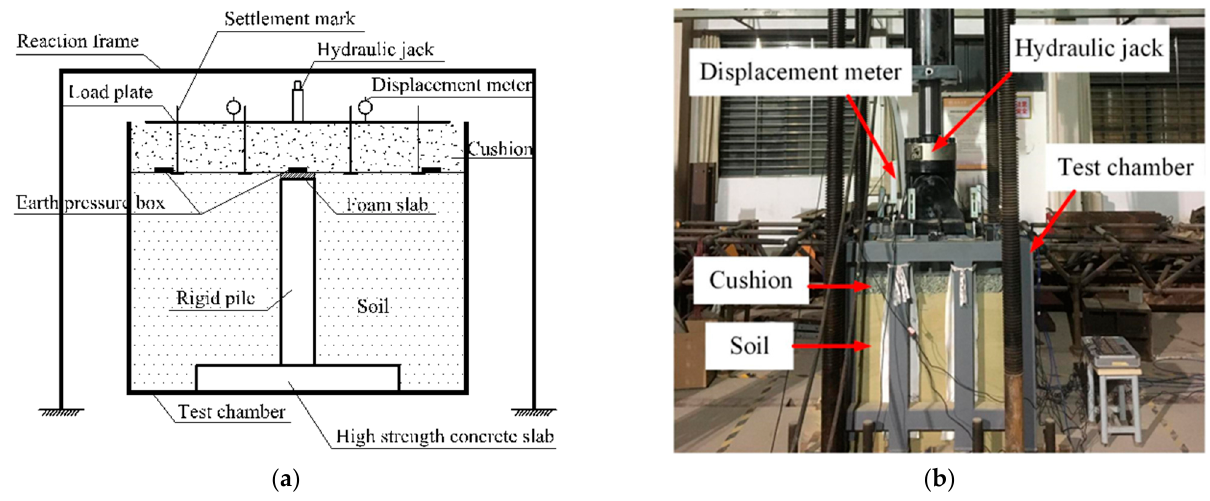
Figure 3. Test loading system: ( a ) diagram of test; ( b ) test photo.